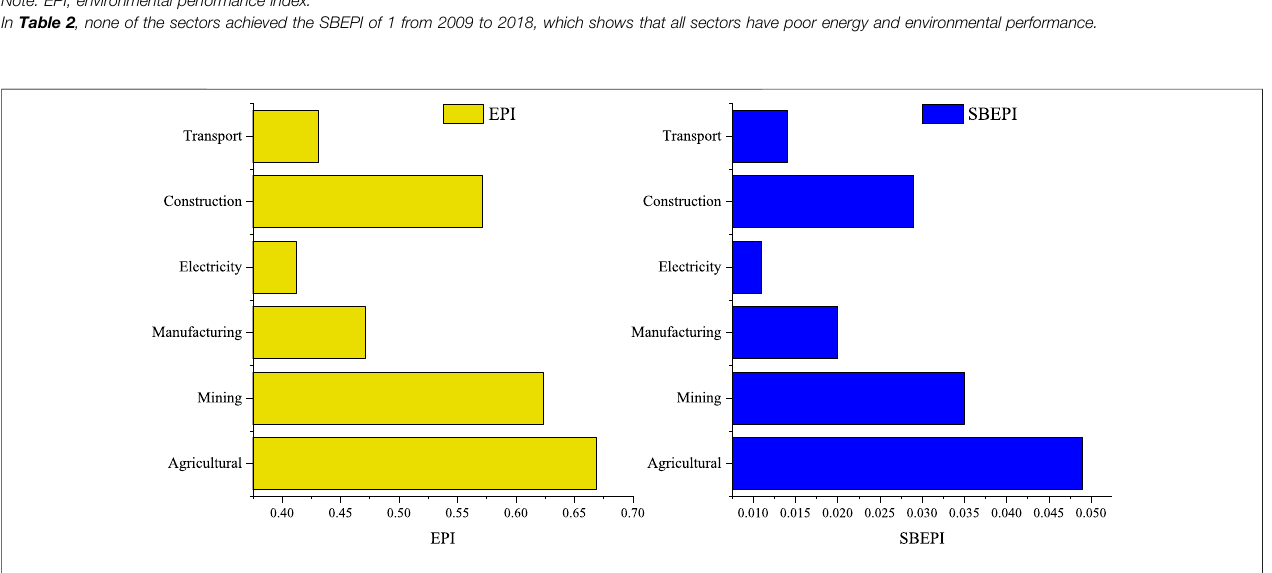
FIGURE 7 | Environmental performance index (EPI) and SBEPI ranking of sectors in